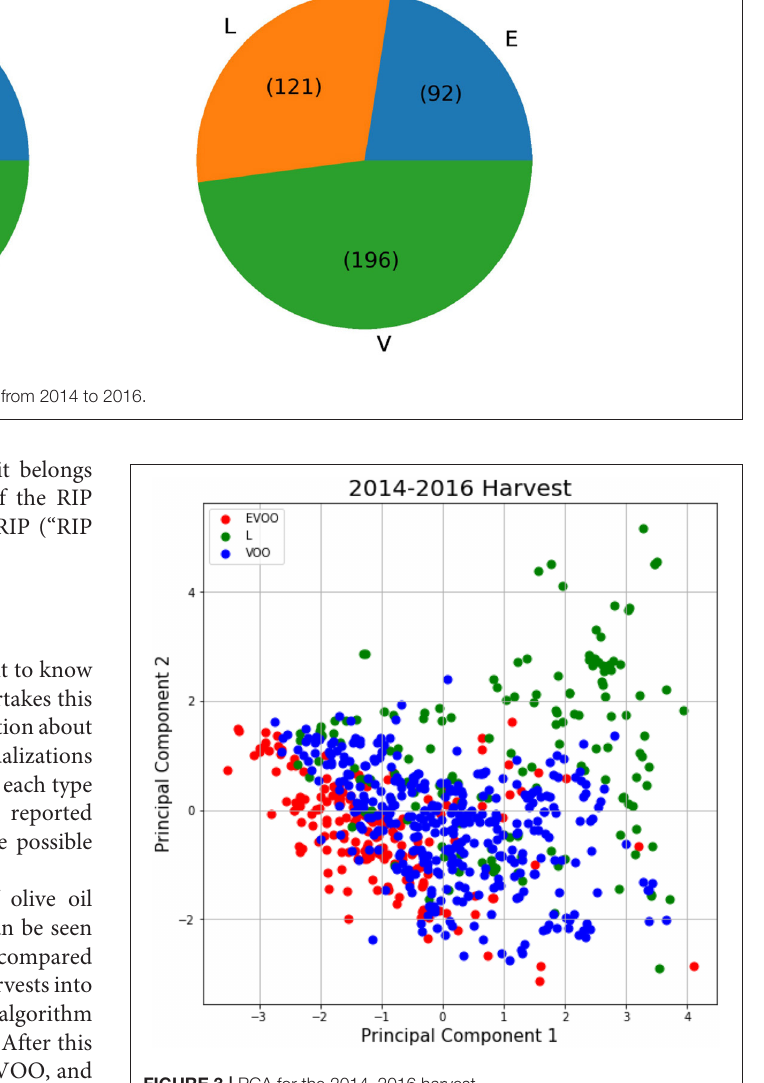
FIGURE 3 | PCA for the 2014–2016